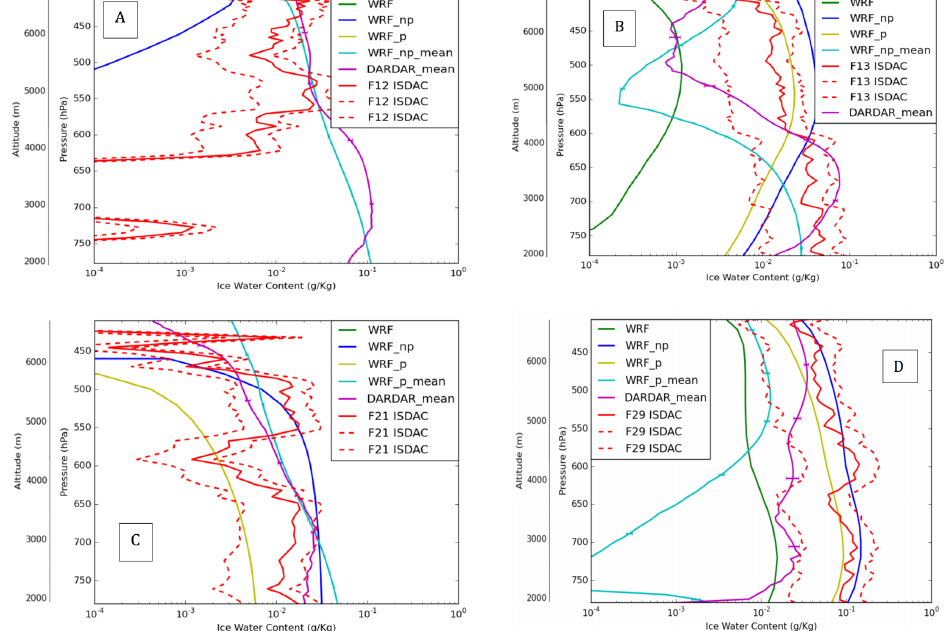
Figure 7. Comparison of the observed and simulated (WRF, WRF_np and WRF_p) vertical profiles of IWC along the flights F12 ( A ), F13 ( B ), F21 ( C ) and F29 ( D ). Simulated profiles averaged along the satellite tracks (WRF_p_mean of WRF_np_mean) are reported together with DARDAR-retrieved average profiles (over the red domain of Figures 5 and